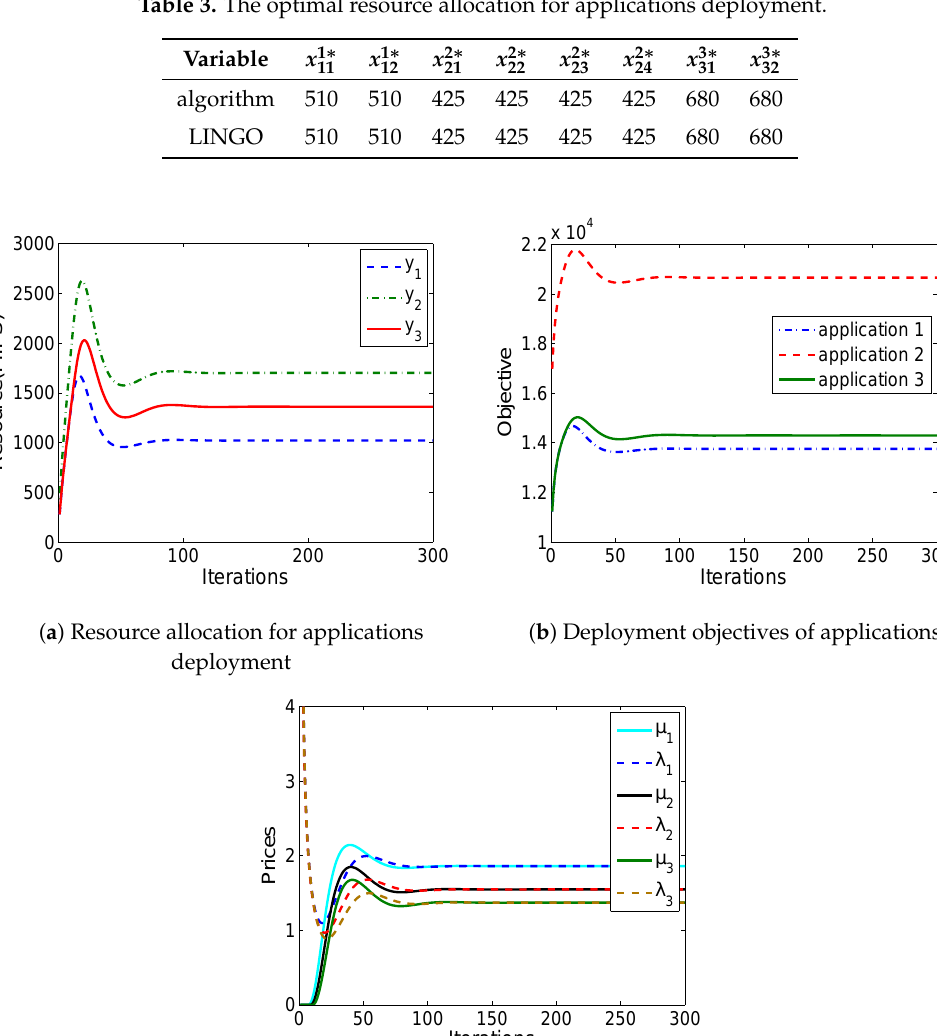
Table 3. The optimal resource allocation for applications deployment.